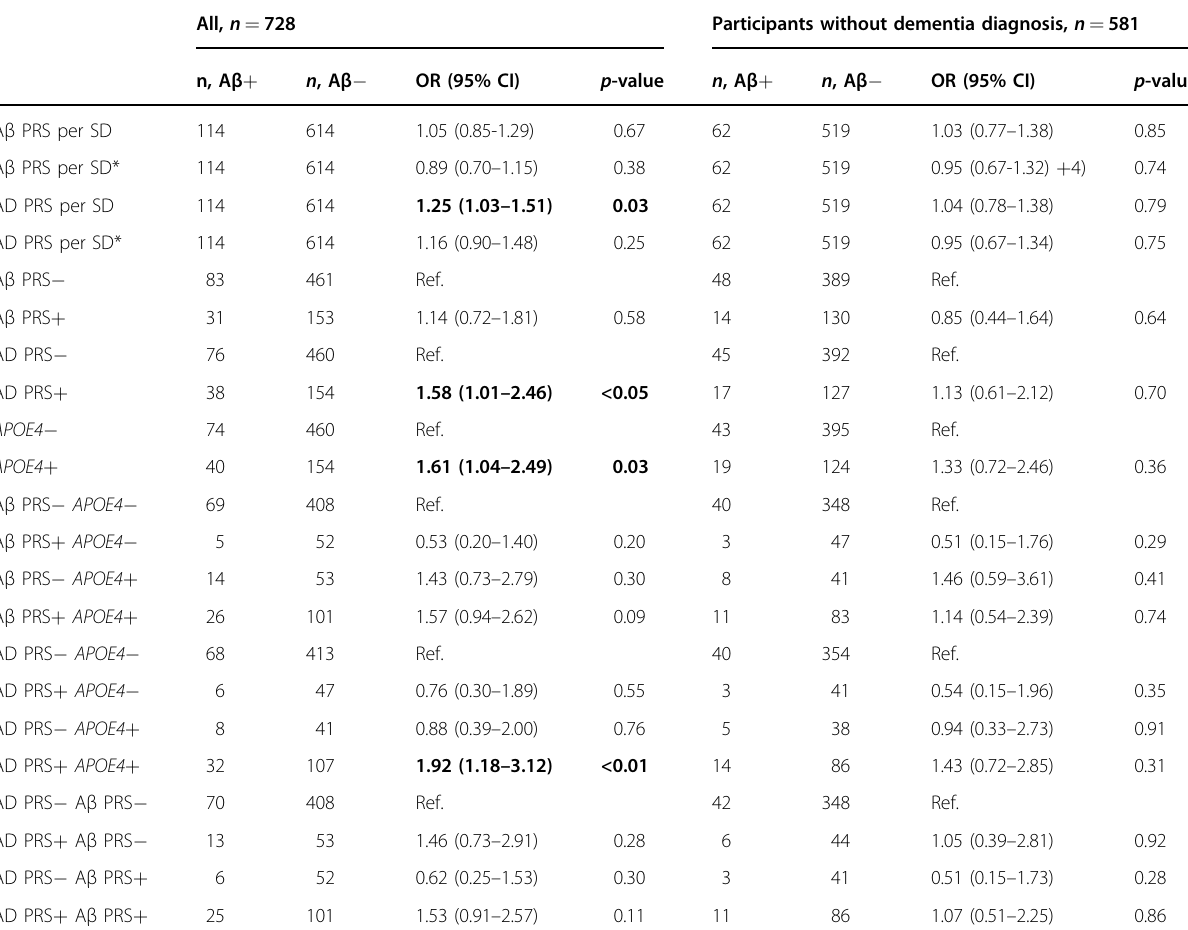
Table 2 Logistic regression results: Association between Alzheimer ’ s and A β polygenic risk scores and A β misfolding. All, n = 728 Participants without dementia diagnosis, n =